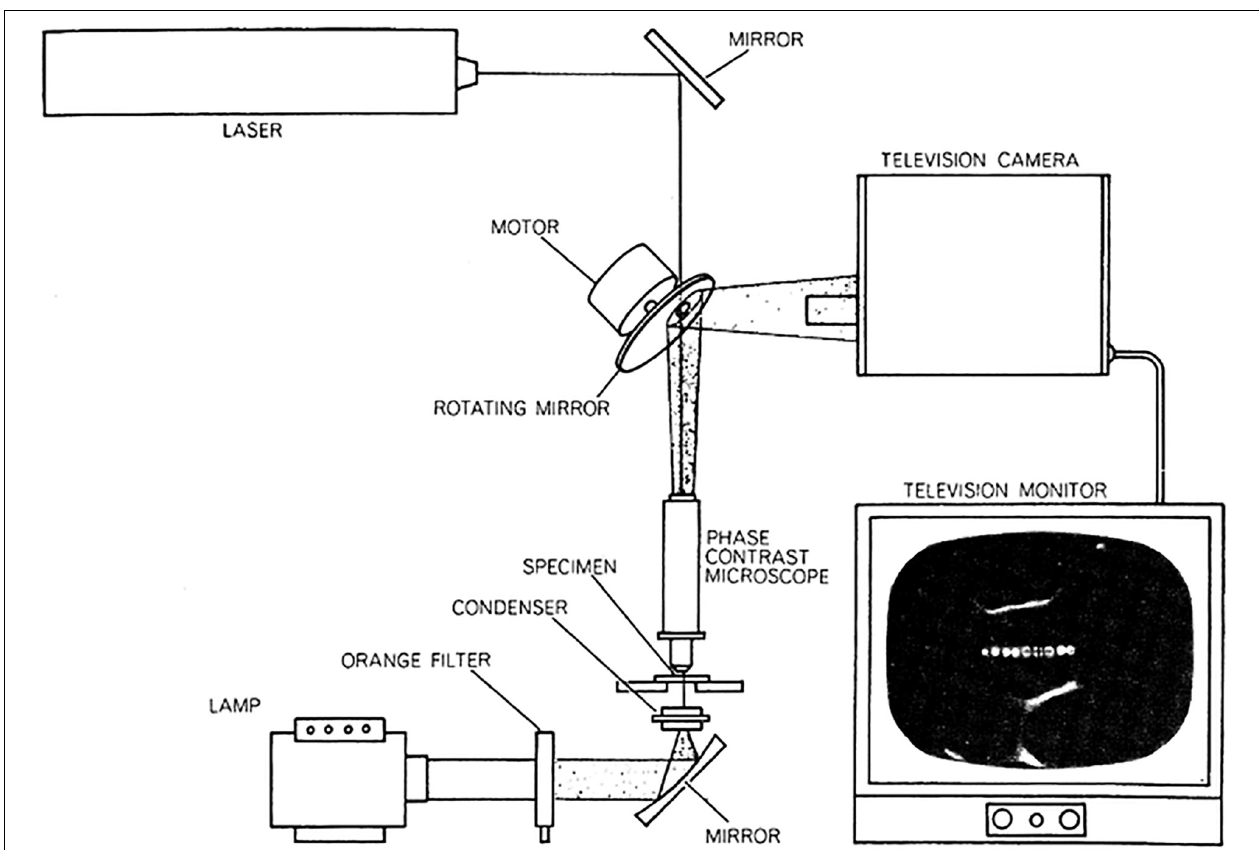
FIGURE 1 | First argon ion laser microbeam microscope. The system utilized a Hughes Aircraft micro second pulsed blue-green (488 and 514 nm) argon ion laser. The 60 Hz pulsed beam passed through a 60 Hz rotating front-surface mirror into the microscope. The microscope image is reflected off the front surfaced mirror into an analog television camera and projected onto the television monitor screen (from Berns and Rounds, 1970; Berns,